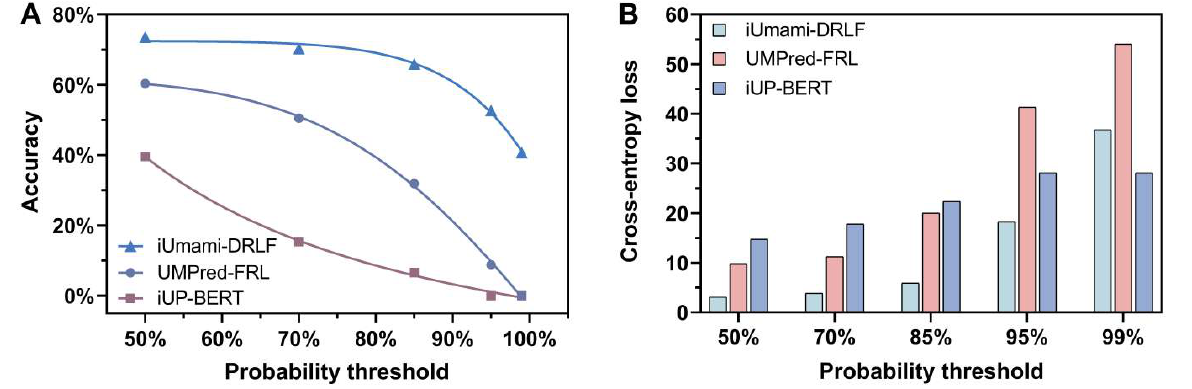
Figure 5. Under varying probability thresholds, the prediction results of iUmami-DRLF (this work), UMPred-FRL, and iUP-BERT are shown using the UMP-VERIFIED dataset. ( A ) is the relationship between prediction accuracy and probability threshold. ( B ) is the cross-entropy loss of the predicted outcome about the probability threshold. The smaller the cross-entropy loss, the better the robustness and accuracy of the model. Note that at the probability thresholds of 95% and 99%, the prediction accuracy of iUP-BERT and UMPred-FRL is 0, and their corresponding cross-entropy losses can be calculated, but they are not